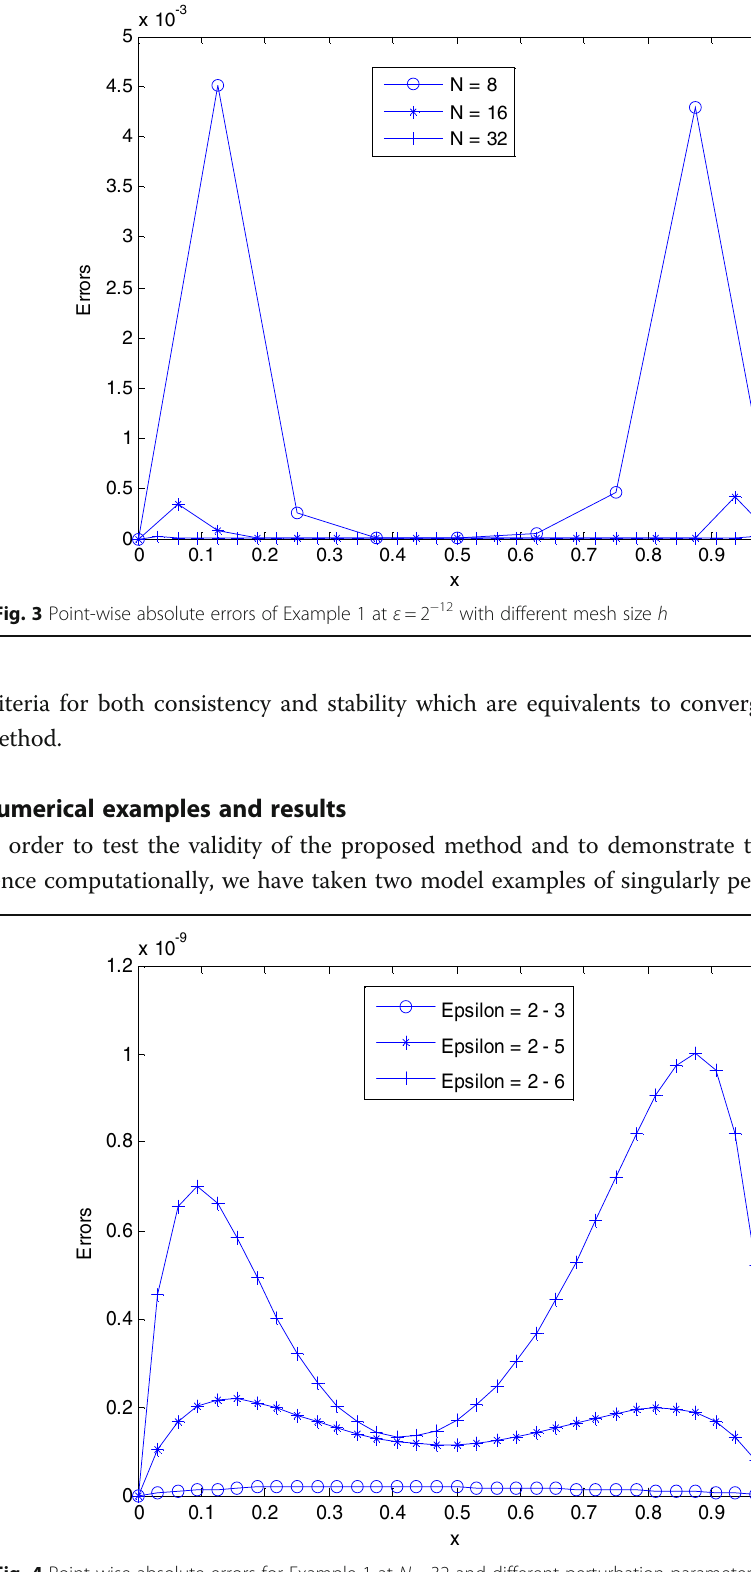
Fig. 4 Point-wise absolute errors for Example 1 at N = 32 and different perturbation